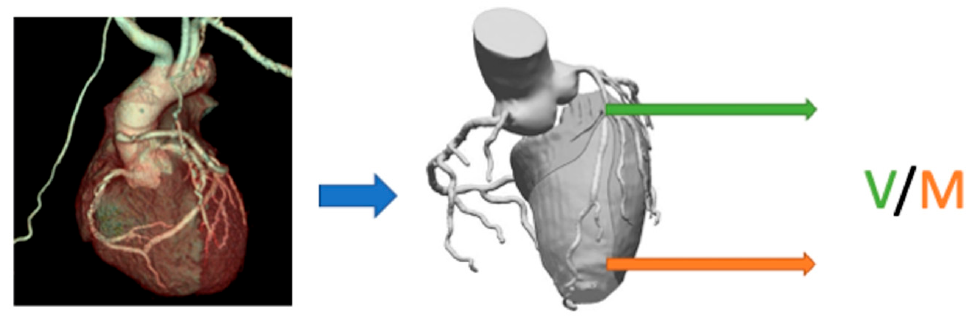
Figure 2. Calculation of V / M ratio from coronary computed tomography angiography (CTA) involves computation of the coronary volume (V, shown in green) and myocardial mass (M, shown in orange). A ratio of < 2 denotes coronary microvascular dysfunction (CMD) in the absence of significant epicardial